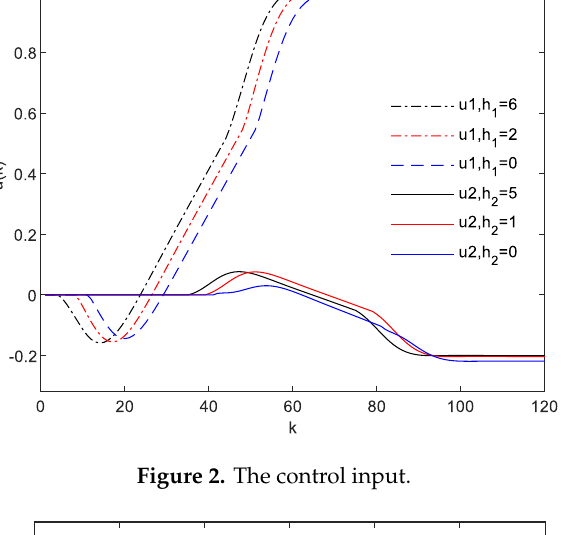
Figure 2. The control input.